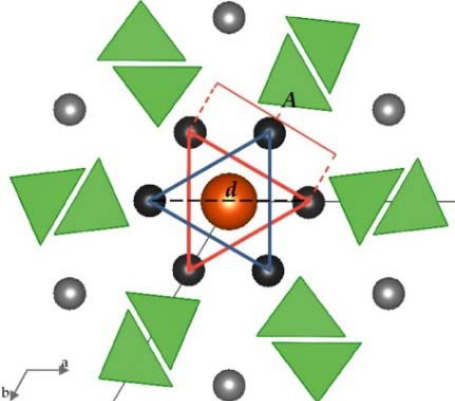
Figure 7. Projection of apatite structure on (001), enabling quantitative determination of the diameter of the channels accommodating X anions. Black atoms are Pb(2), grey atoms are Pb(1), an orange atom is X anion, and the green triangles are AsO 4 tetrahedra. For clarity, oxygen atoms are not shown, and the size of ions is not set to scale. Both blue and red triangles are formed by Pb(2) cations positioned on the same plane. These triangles are located parallel to each other in the channel.